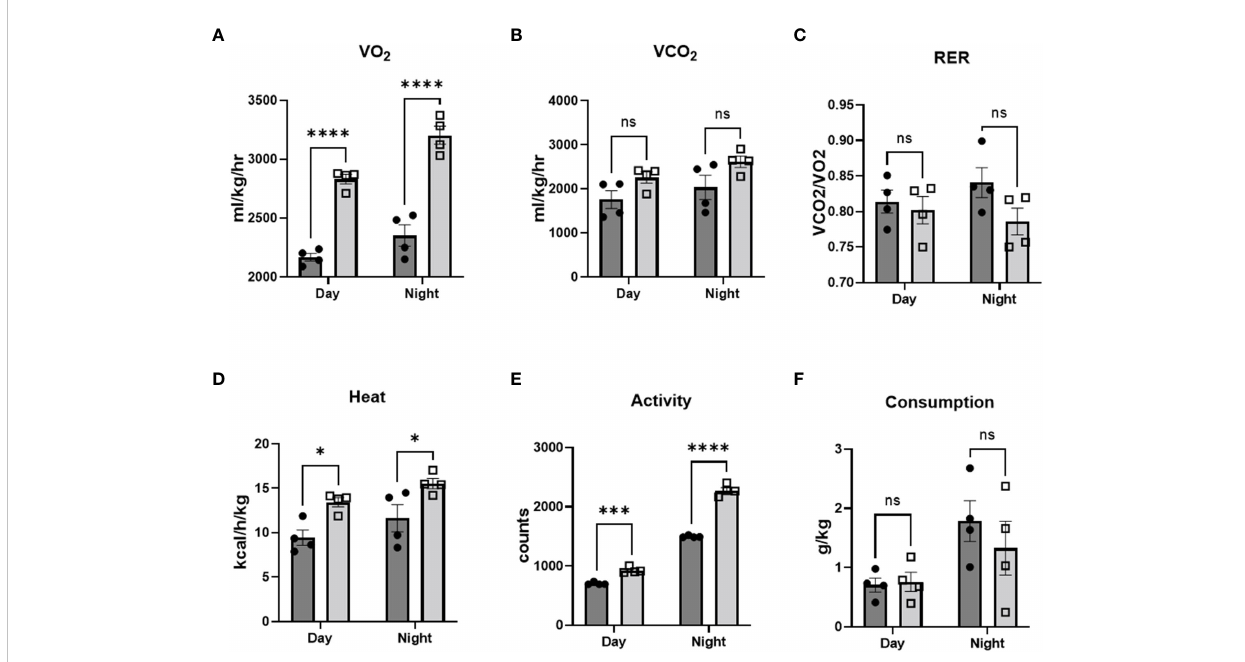
FIGURE 2 MRL/lpr mice were hypermetabolic. Comprehensive laboratory animal monitoring system (CLAMS) was performed at age of 14 weeks. VO 2 (A) , CO 2 (B) , heat production (D) , activity (E) , and food consumption (F) were measured, and respiratory exchange ratio (C) was calculated. n=4.